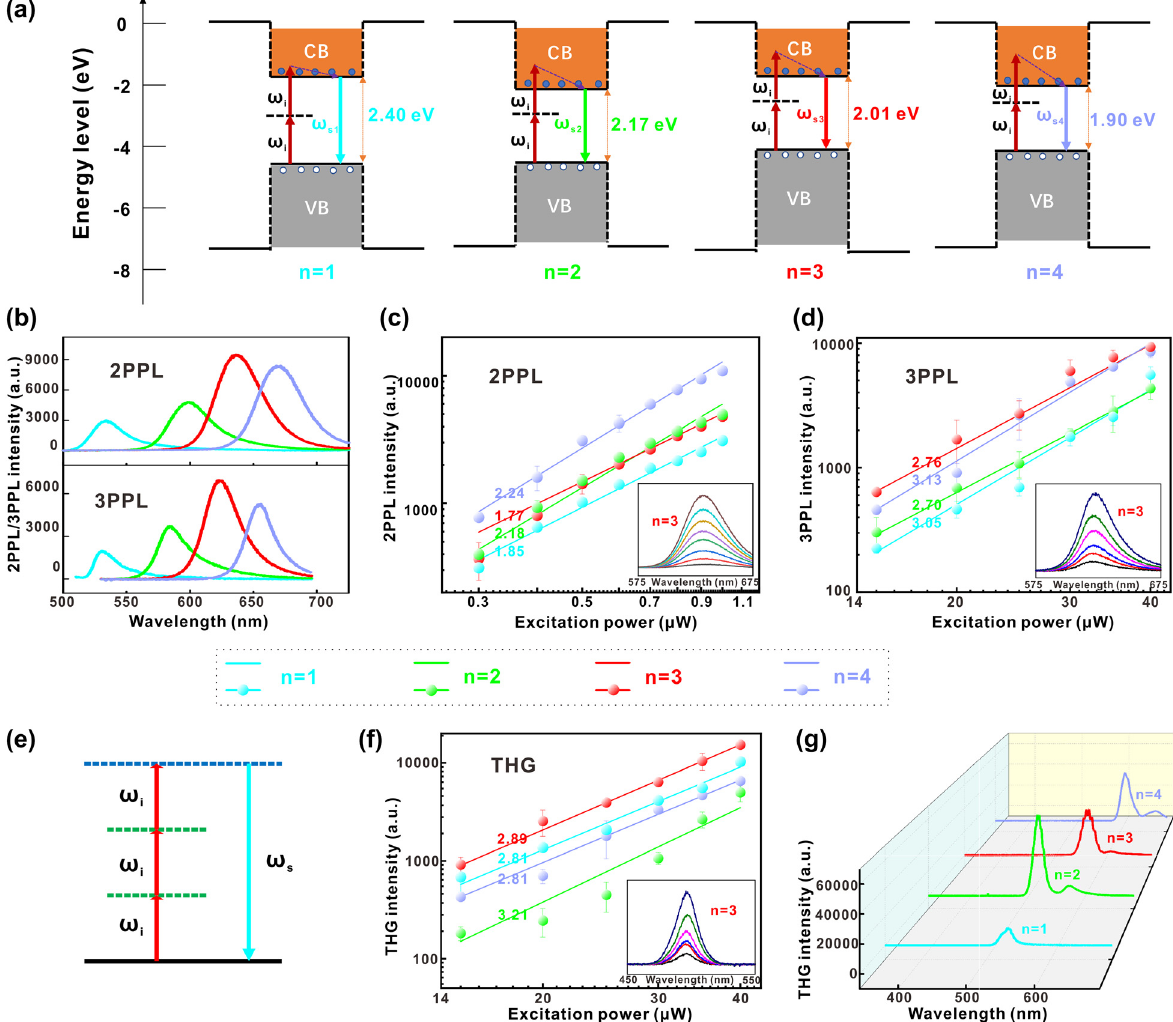
Figure 2: Multi-photon photoluminescence and THG responses of the 2D RPPs (BA) 2 (MA) n − 1 Pb n I 3 n + 1 ( n = 1, 2, 3, 4) nanosheets. (a) Energy band schematic diagrams of two photons absorption in single quantum well of 2D RPP ( n = 1, 2, 3, 4) nanosheets. (b) Typical 2PPL/ 3PPLspectraofdifferent2DRPPs( n =1,2,3,4).Excitationpowersare1and30 μ Wfor2PPLand3PPL,respectively.Theexcitationwavelengths are 800 and 1500 nm for the 2PPL and 3PPL, respectively. (c) and (d) Peak intensities of 2PPL/3PPL in 2D RPP ( n = 1, 2, 3, 4) nanosheets under differentexcitationpowers.Linear fi ttingsarecarriedoutonthedoublelogarithmiccoordinate system.The insetsshow 2PPL/3PPLspectraof 2D RPPs ( n = 3) under different excitation powers (0.3 – 1.0 μ W, step = 0.1 μ W for 2PPL; 15 – 40 μ W, step = 5 μ W for 3PPL). (e) Energy